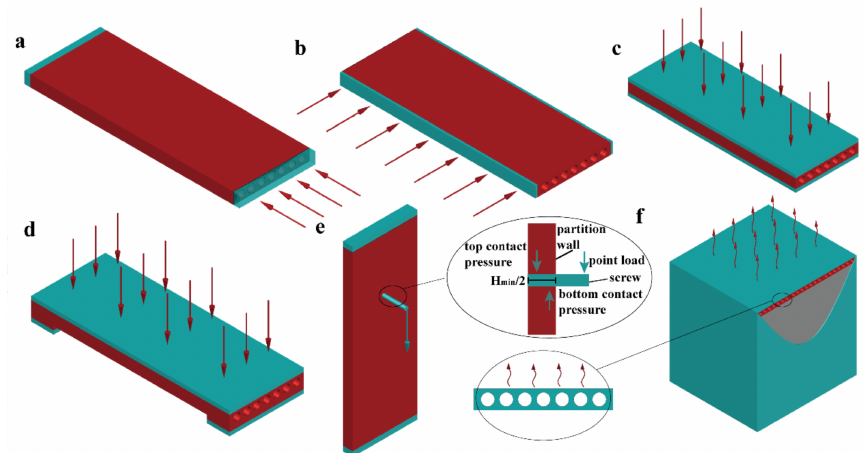
Figure 2. Boundary conditions of the partition wall (load 2a–load 2f): ( a – c ) uniformed loading in different directions; ( d ) bending under the uniformed loads; ( e ) hanging test boundary condition; and, ( f ) heat transfer boundary